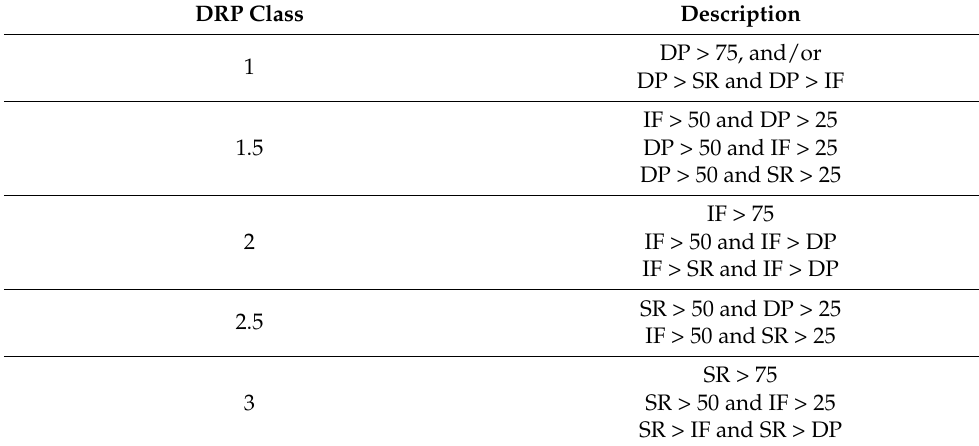
Table 4. Dominant runoff classification in WaSIM.